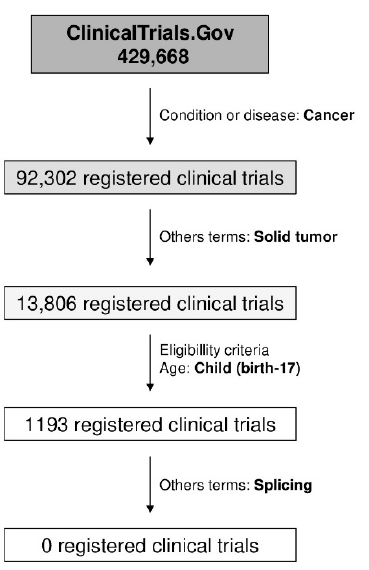
Figure 3. Clinical trials that include research on splicing in pediatric cancer. There are 429,668 registered clinical trials in the ClinicalTrial.gov database at the time of this review. The number is minimized to 13,806 when filtering the trials by the terms cancer and solid tumor. Taking into account the age (child: birth–17 years), there are 1193 clinical trials. When the term splicing is included, no clinical trials are